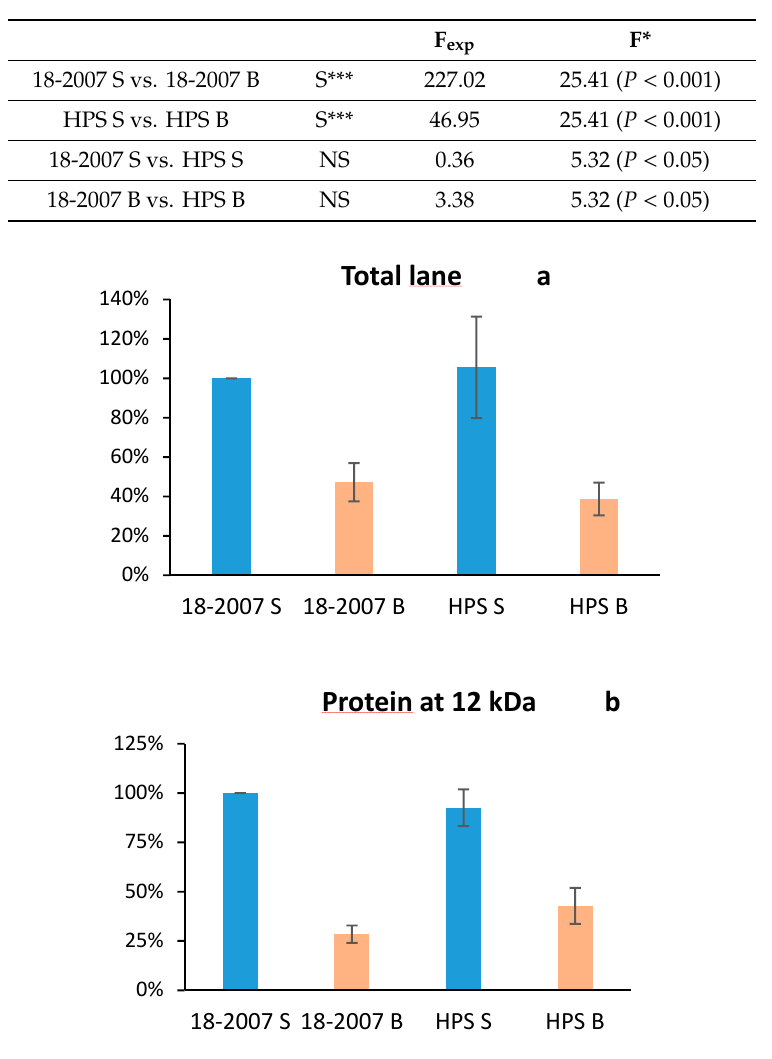
Table 1. Total protein contents analyzed by ANOVA. S***, Significant statistical di ff erences ( P < 0.001) between clean and botrytized wines (yellow). NS, Non-Significant statistical di ff erences ( P > 0.05) between clean wines (blue) and between botrytized wines (grey). F exp , experimental Fisher value. F*, critical Fisher value.